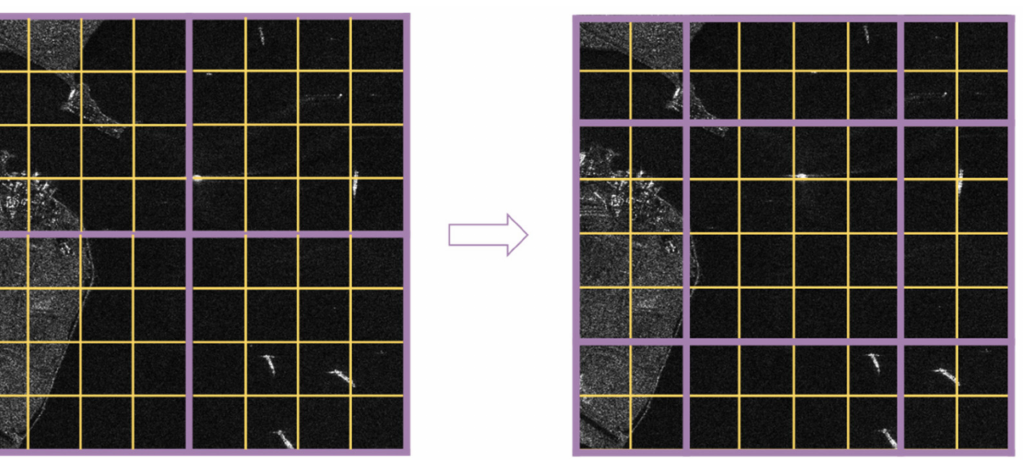
Figure 3. The operation of shifted